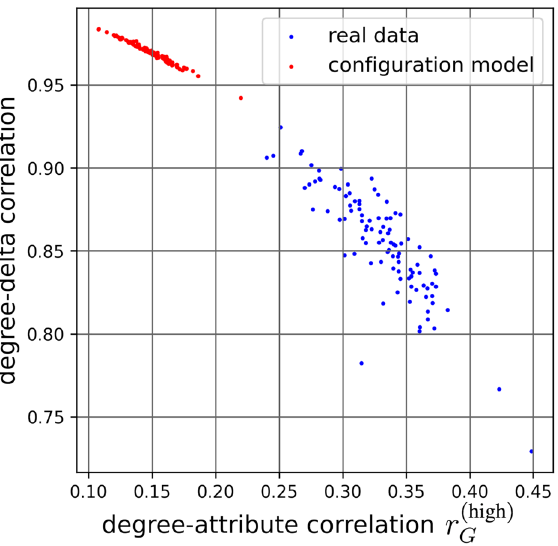
Figure 6. For Facebook100 data, it’s possible to find SGFP-failing attribute samples with r d , a up to 0.45. When we remove social structure with a configuration model, the correlations we find with Simplex optimization are much